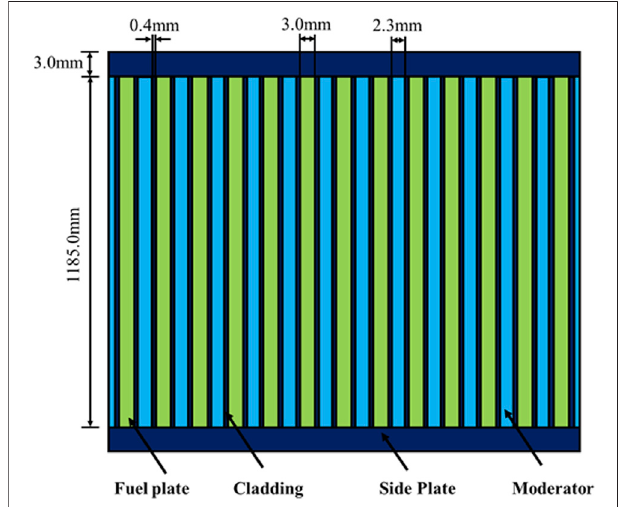
FIGURE 1 | Schematic of plate fuel